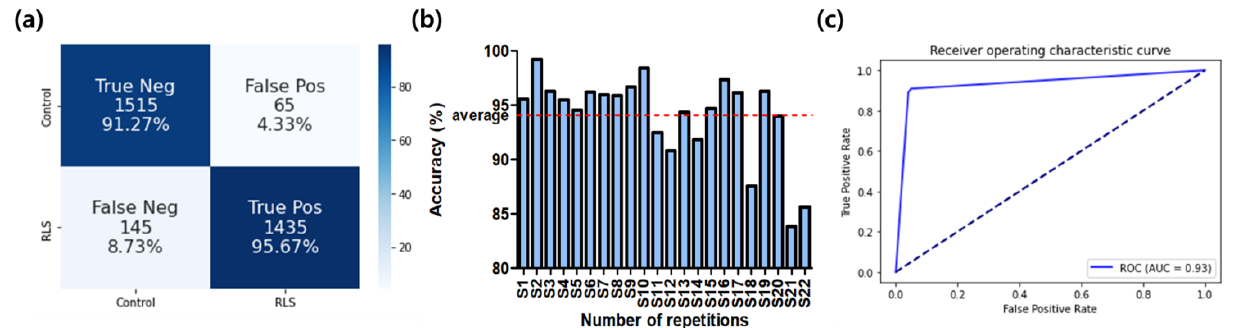
Figure 2. The classification performance of the CNN classifier. ( a ) Confusion matrix; ( b ) classification accuracies for all subjects; ( c ) ROC curve.